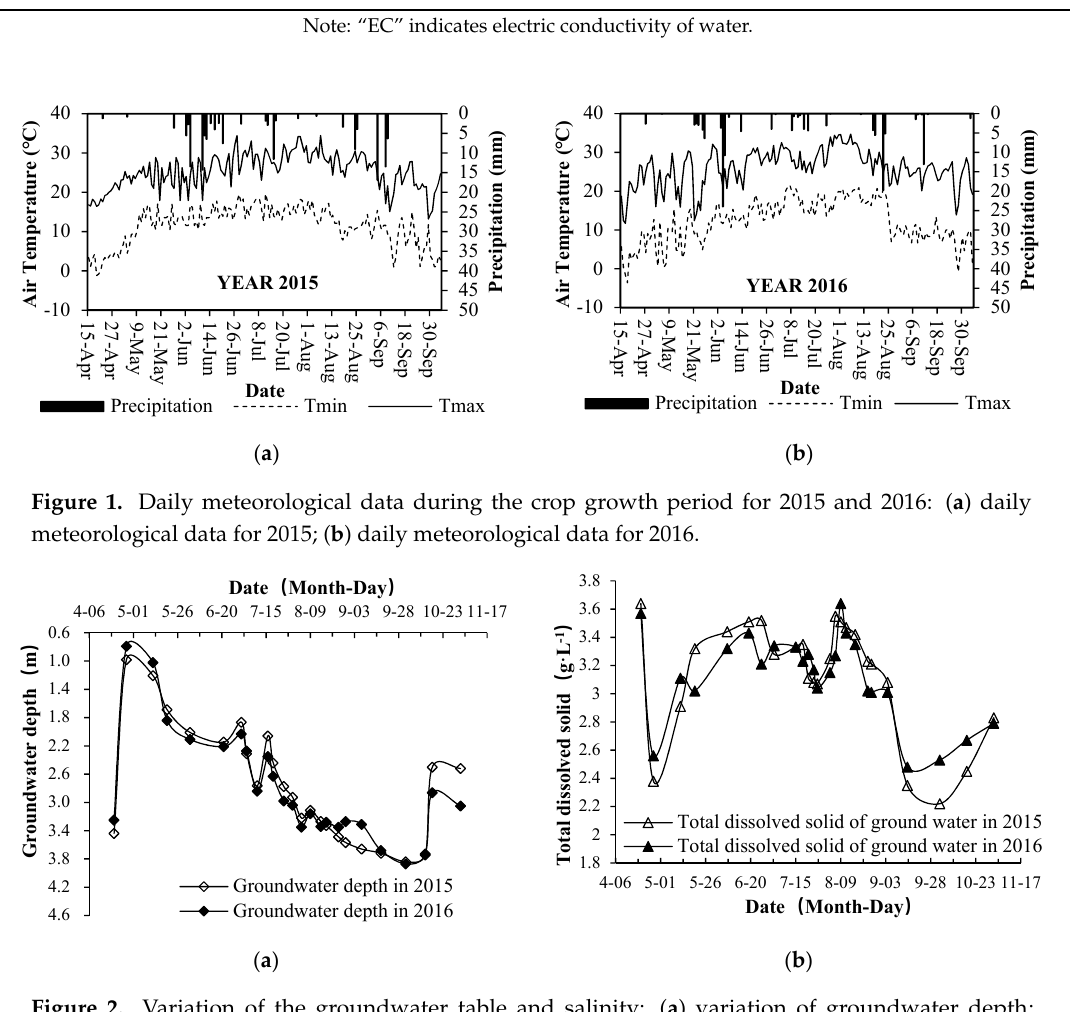
Figure 2. Variation of the groundwater table and salinity: ( a ) variation of groundwater depth; ( b ) variation of groundwater salinity.